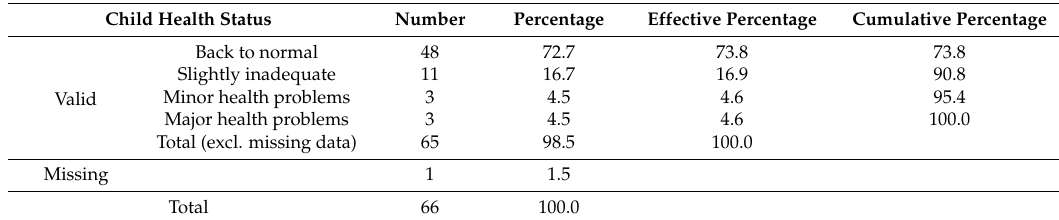
Table 2. Children’s physical